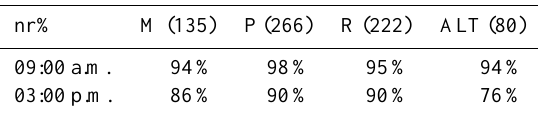
Table 5. Number of stations (in %) for which the root mean square error (RMSE) after analysis is reduced, the RMSE calculated as in Table 4. The total number of sites for each type is indicated in the first line.